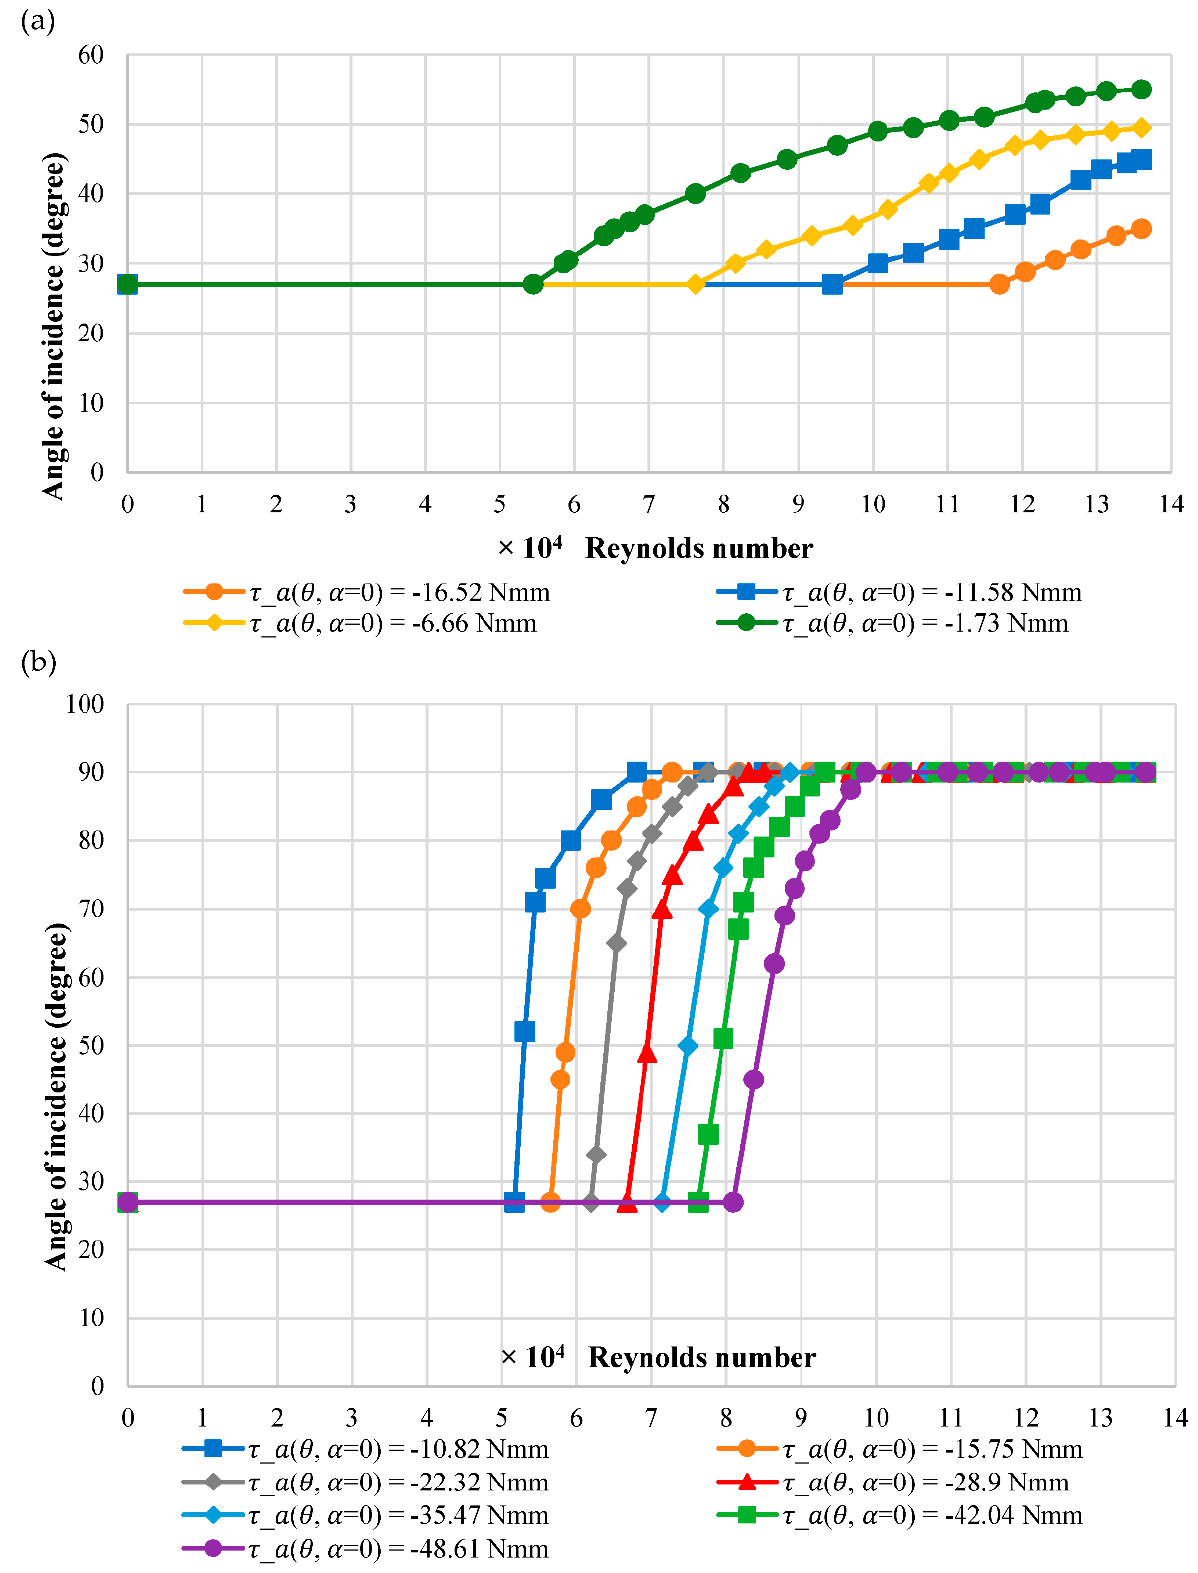
Figure 8. Response of the angle of incidence against flow velocity for ( a ) MP3 and ( b ) MP4 of NACA 6412.